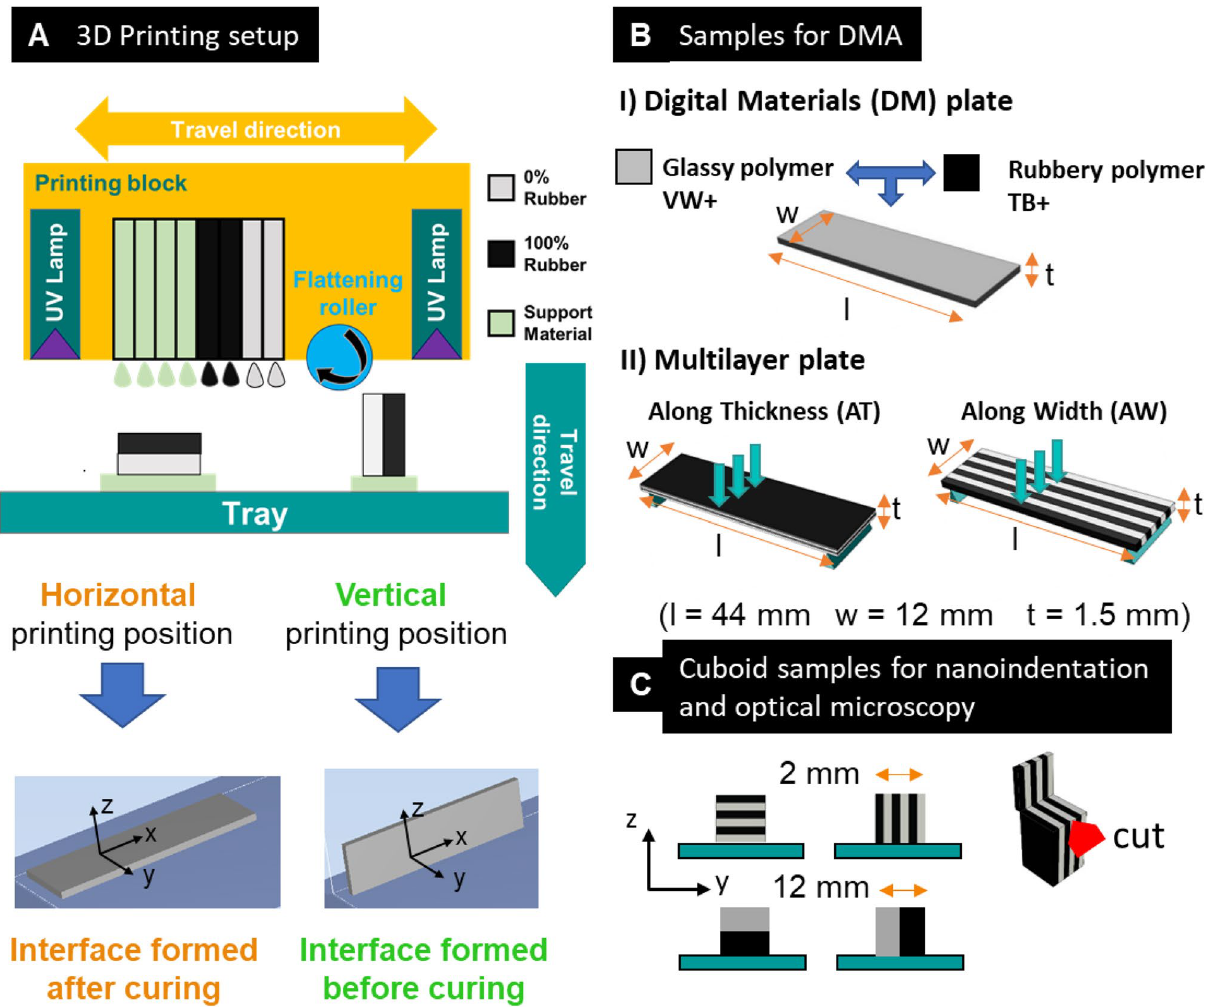
Figure 1. ( A ) Scheme of the polyjet printing process considering bimaterial samples fabricated in horizontal or vertical printing position. The two different printing modalities imply that the bimaterial interface is formed after or before UV curing. ( B ) Plate-like samples consisting of I) digital materials and II) multilayer composites alternating compliant (TangoBlackPlus, TB +) and stiff (VeroWhitePlus, VW +) layers stacked either along the thickness (AT) or the width (AW) of the plate. All samples were assessed with Dynamic Mechanical Analysis (DMA). C) 3D-printed bimaterial cuboid specimens used to characterize interface size with nanoindentation (top) and optical microscopy (bottom). Before nanoindentation, sample surface was smoothed with cryomicrotome: the red arrow indicates the direction of the cut, perpendicular to the